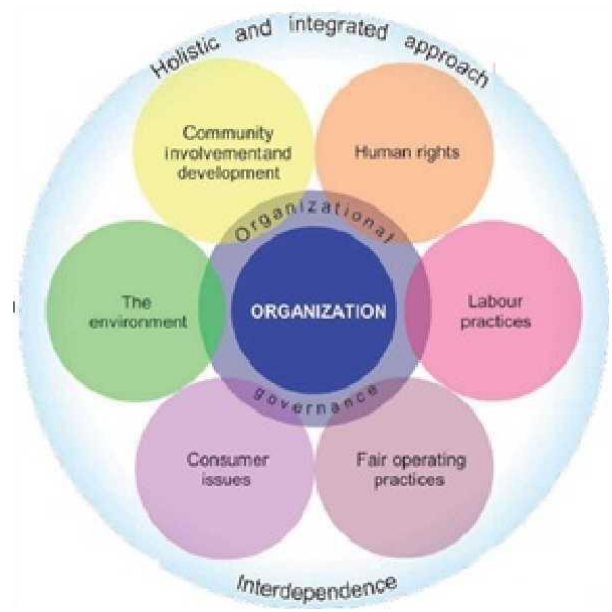
Figure 1 The inter-relationship of Seven Core Subjects (ISO 26000, 2010, p